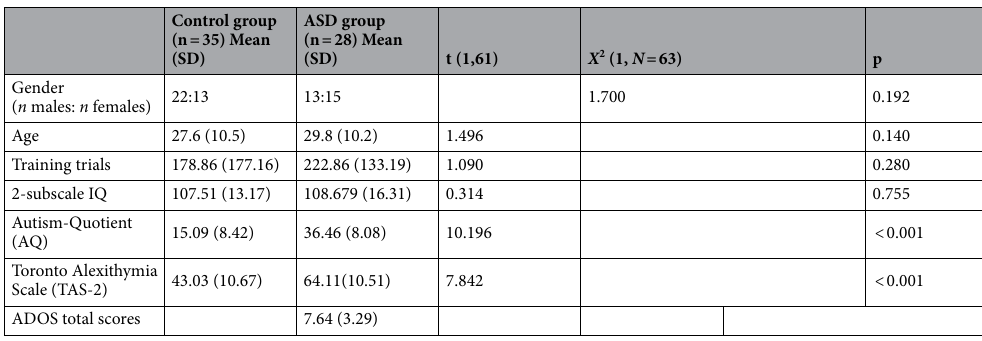
Table 1. Demographic information. IQ was assessed with the Wechsler Abbreviated Scale of Intelligence-2 (WASI-2). SD refers to standard deviation. Training trials, IQ and gender did not significantly differ between the